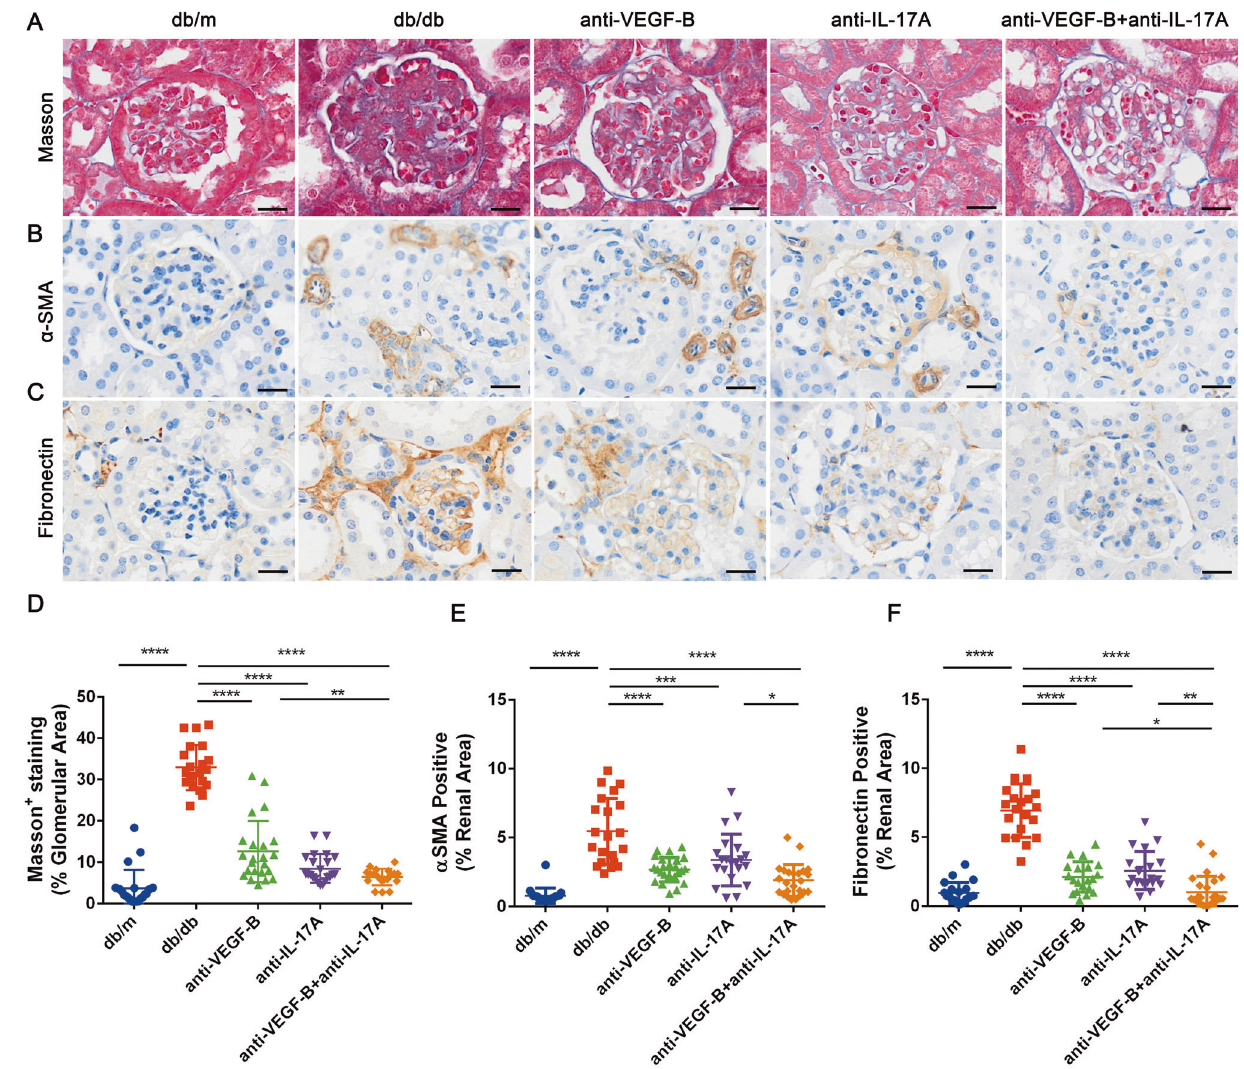
Fig. 3 Anti-VEGF-B and anti-IL-17A treatment simultaneously inhibited the renal fi brosis response in db/db mice of the DKD model. A Deposition of collagen fi ber was determined according to Masson staining of db/db mice kidney sections (scale bar: 10 μ m). B and C Deposition of Collagen fi ber deposition including α -SMA and fi bronectin in kidney sections by immunohistochemistry analysis (scale bar: 10 μ m). D Quanti fi cation of the collagen fi ber deposition of Masson staining of db/db mice kidney sections. E and F Quanti fi cation of the expression of fi brosis markers of fi bronectin and α -SMA in kidney sections in DKD mice after anti-VEGF-B or/and anti-IL-17A treatment. The data were presented as means ± SD, n = 4 mice in each group, per section/per mice, 5 glomerulus or tubulointerstitial/per section ( D – F ), **** P < 0.0001, ** P < 0.01, * P < 0.05. The statistical signi fi cance was analyzed by one-way ANOVA with Tukey ’ s multiple-comparisons